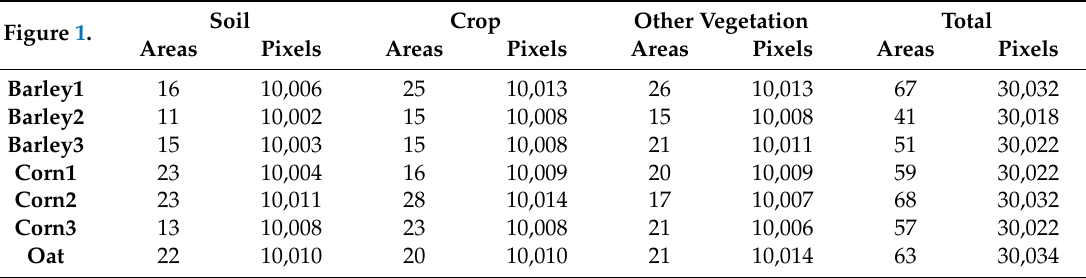
Table 3. Number of training areas per class for